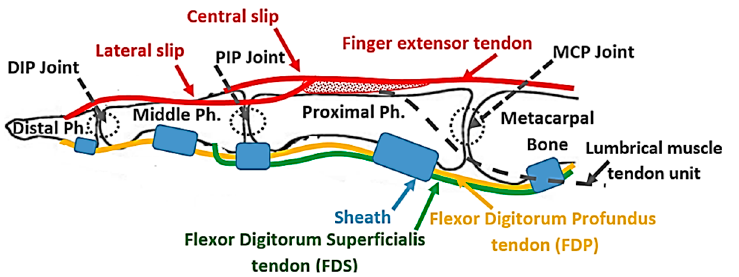
Figure 1. Anatomic structure of the finger with the flexor digitorum profundus (FDP) tendon and flexor digitorum superficialis (FDS) tendon (yellow and green lines, respectively), and extensor tendon (red line). Tendon sheets are presented in blue.